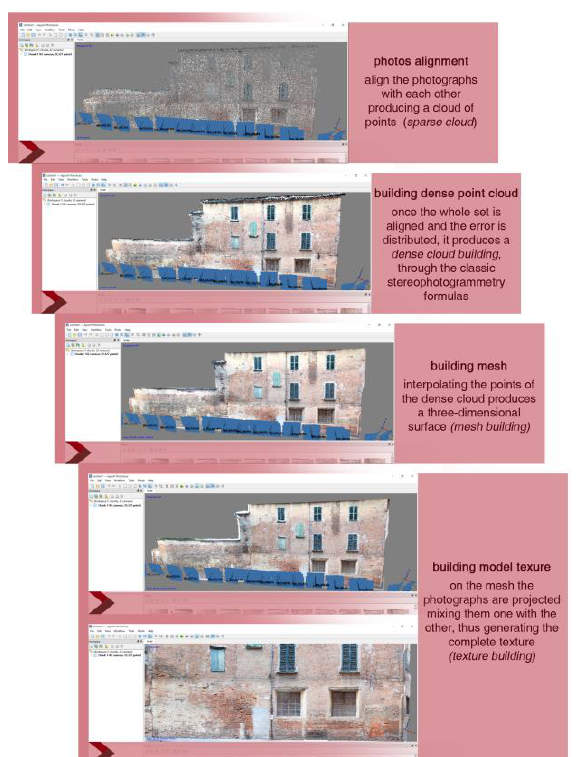
Figure 5. Model creation.